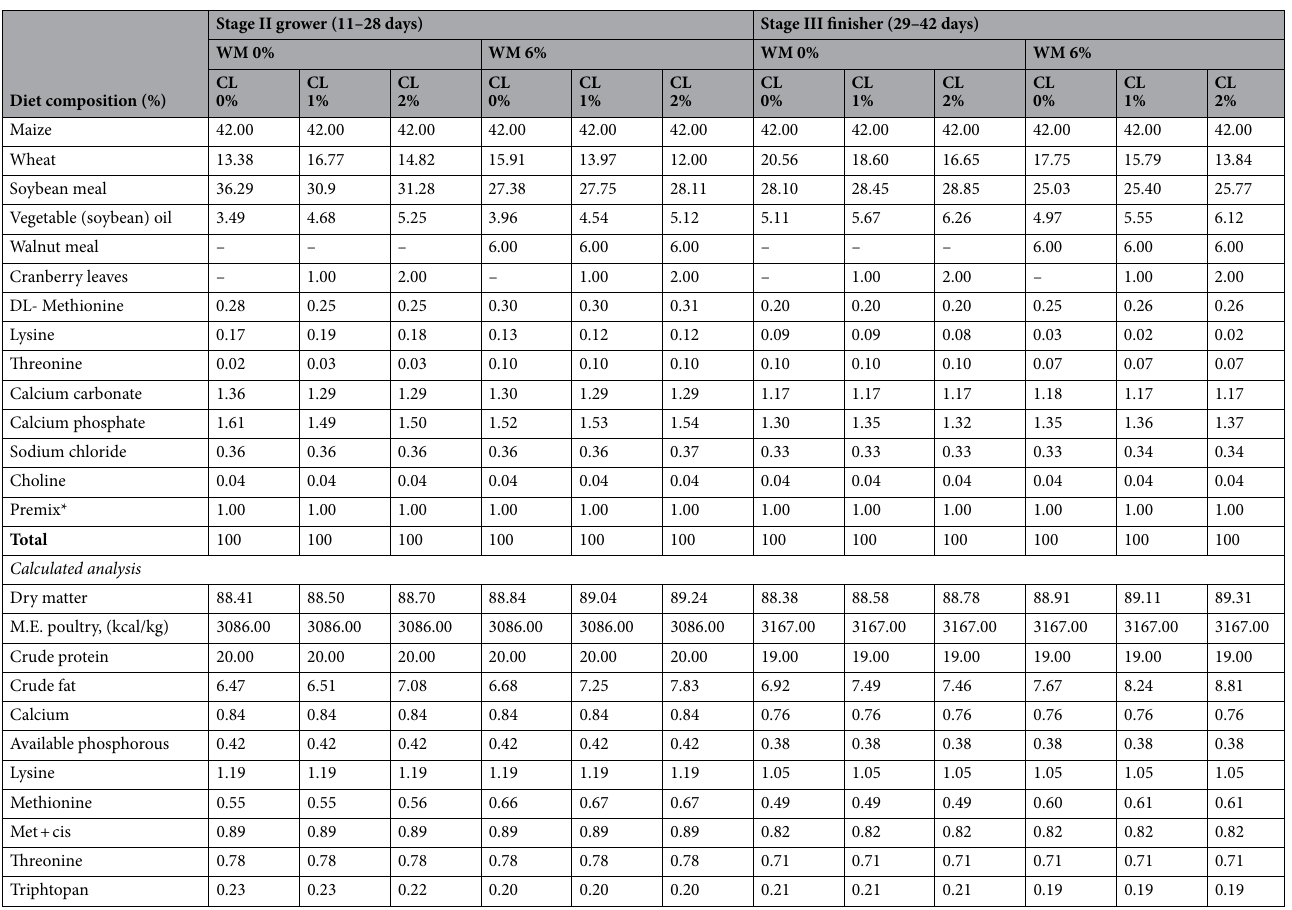
Table 7. Ingredients and chemical composition of broilers’ diets. *1 kg of premix contains: 1,100,000 IU/ kg vitamin A; 200,000 IU/kg vitamin D3; 2700 IU/kg vitamin E; 300 mg/kg vitamin K; 200 mg/kg Vit.